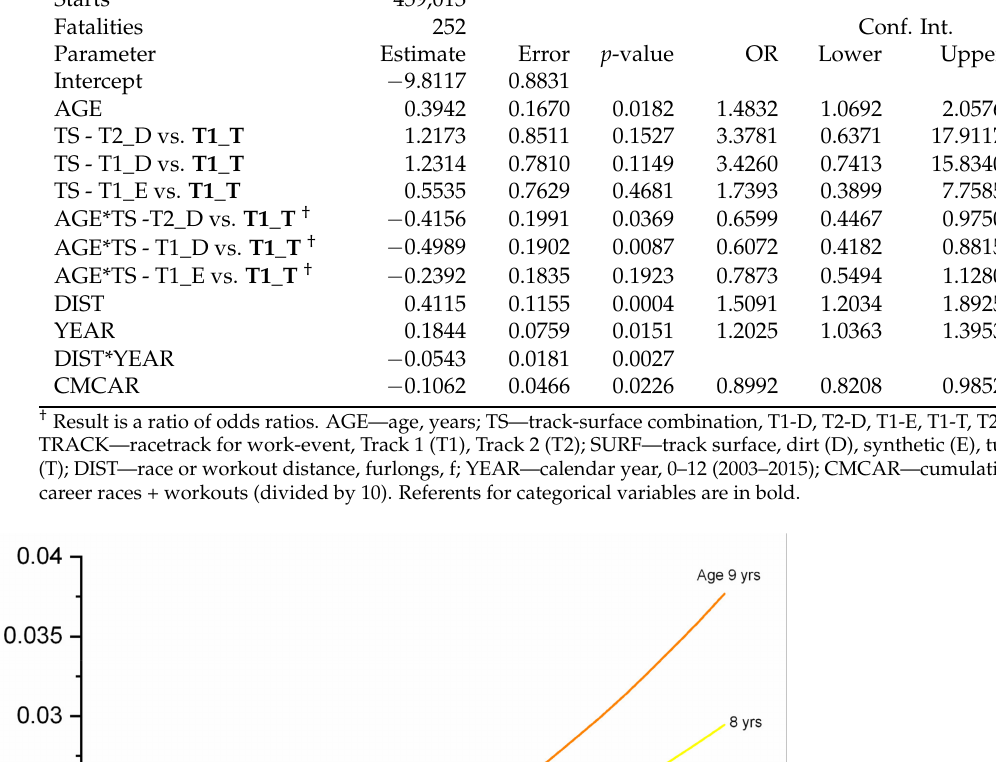
Table 5. Logistic Regression Modelling of Associations with Equine Fatality in Ontario Racing for Thoroughbred Workout Events, by Event, 2003–2015. Starts 459,013 252 Conf. Int.